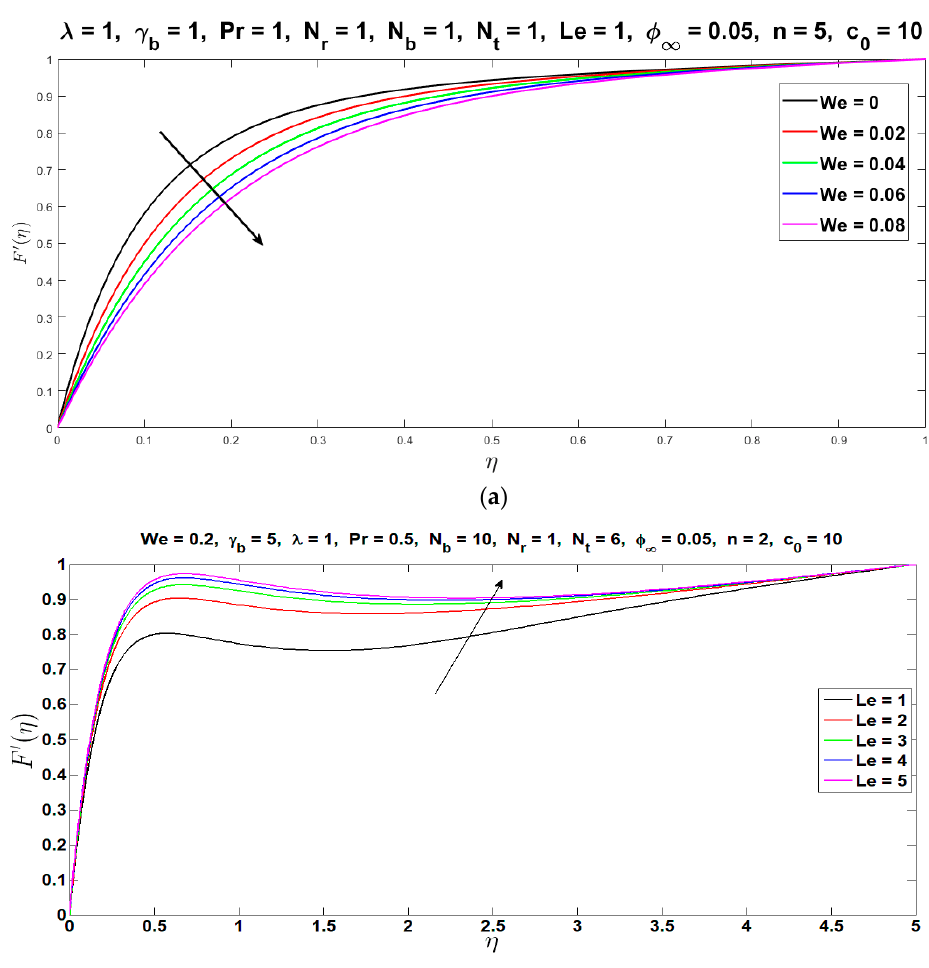
Figure 2. ( a ) Influence of 𝛾 (cid:3029) over 𝐹 (cid:4593) . ( b ) Effects of 𝑁 (cid:3047) over 𝐹 (cid:4593) .